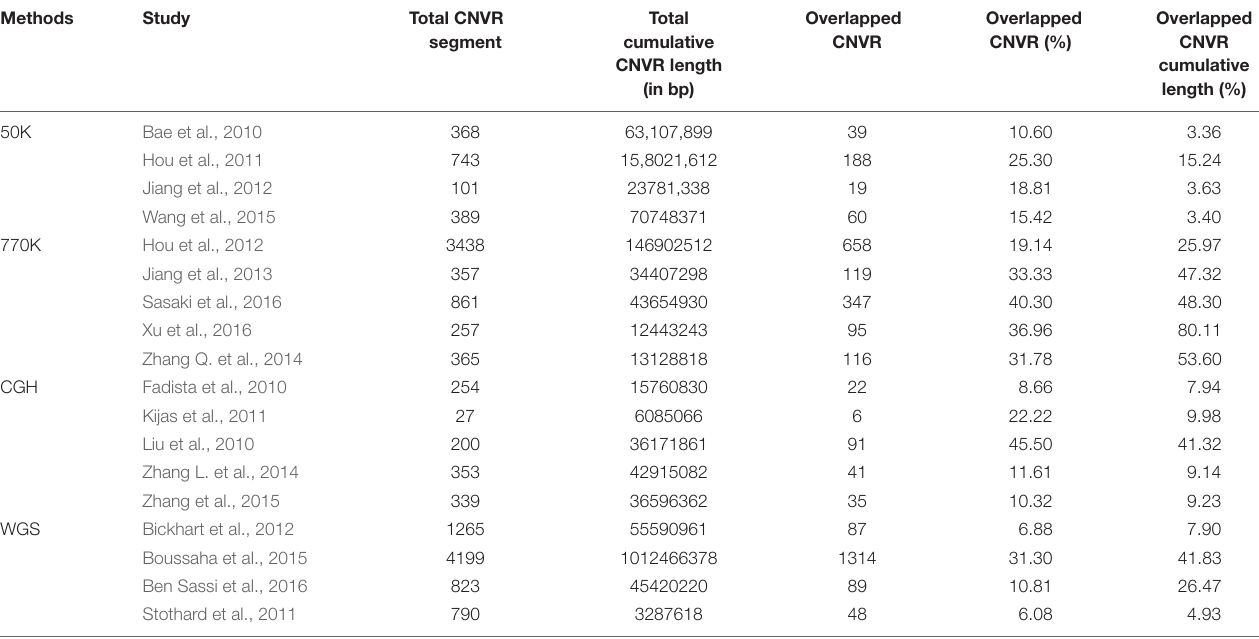
TABLE 1 | Comparison between CNVRs identified in the present study with previous studies in terms of count and length.